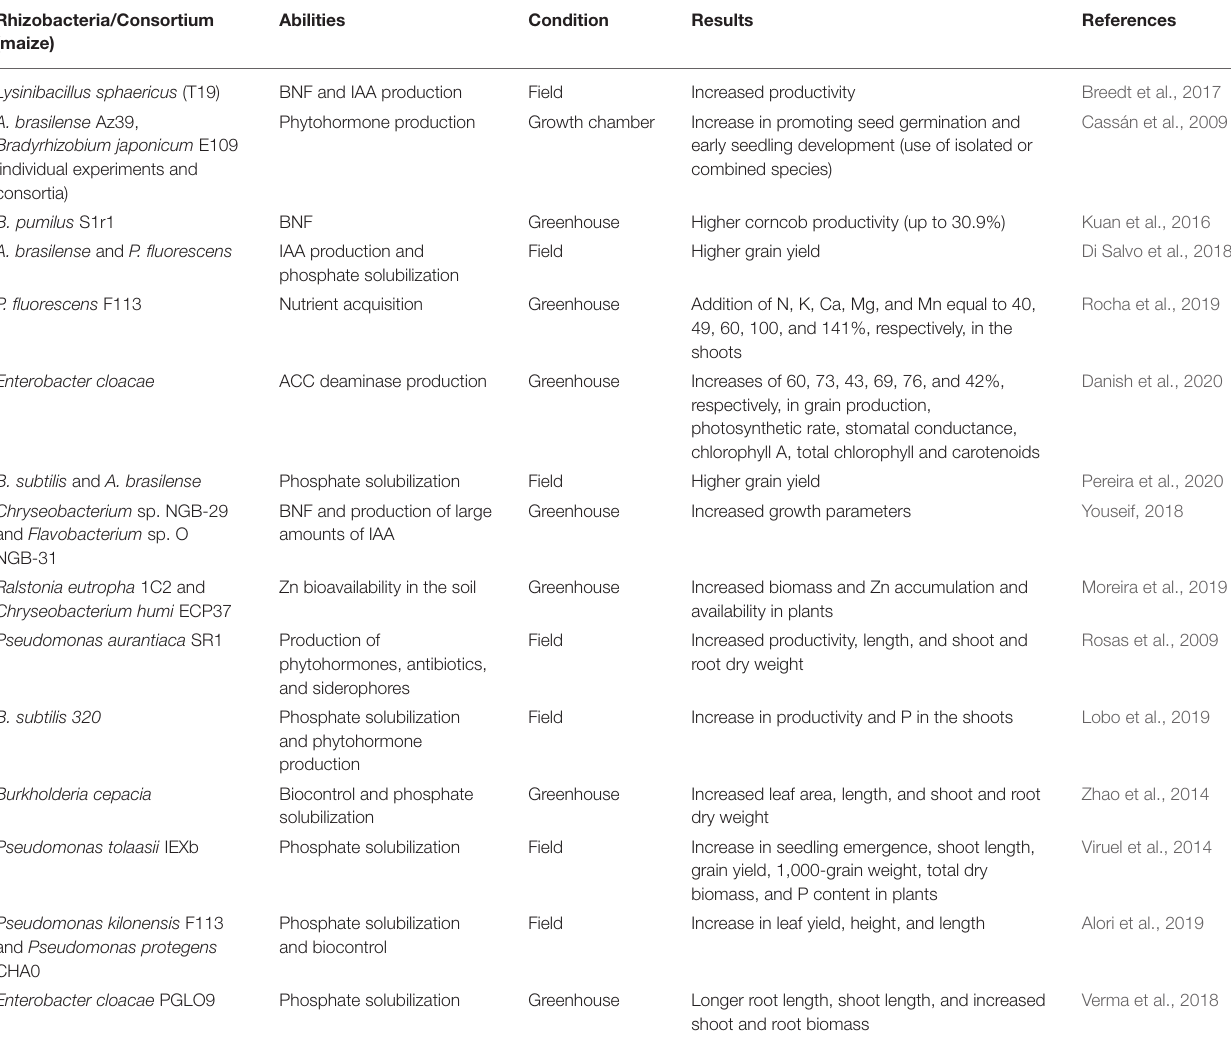
TABLE 1 | Bacteria specie, abilities, experiment condition, and results promoted by the application of many plant growth- promoting rhizobacteria in maize